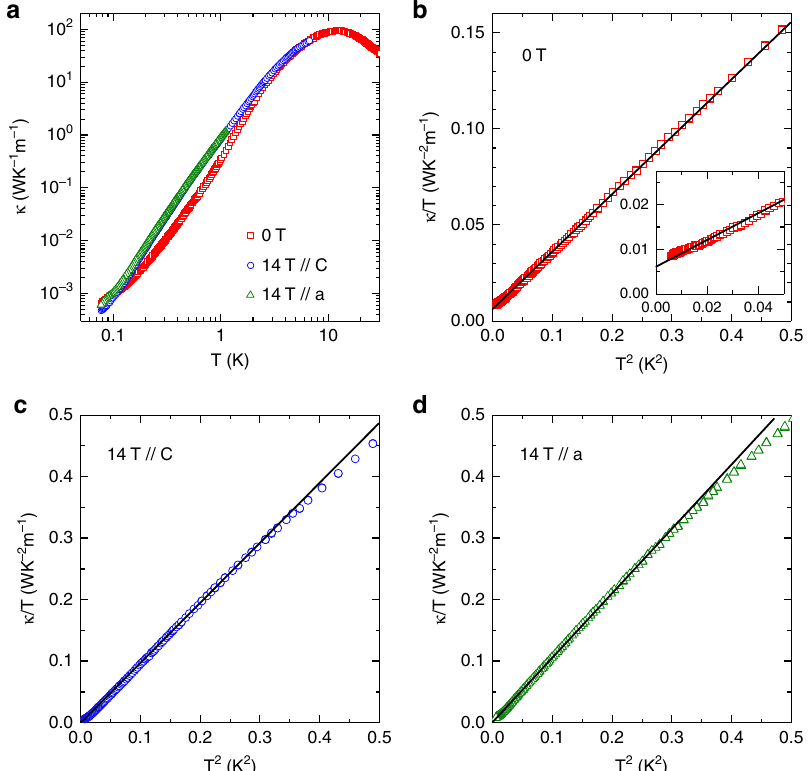
Fig. 2 Ultralow-temperature thermal conductivity of Na 2 BaCo(PO 4 ) 2 . a The zero- fi eld thermal conductivity of Na 2 BaCo(PO 4 ) 2 in temperature range of 70 mK – 30 K. The heat current is along the a axis. The peak at 12 K is the so-called phonon peak. Also shown are the thermal conductivity in 14 T magnetic fi eld along the c or the a axis. In most of this temperature region, high magnetic fi eld enhances the thermal conductivity. b Data in zero fi eld plotted in κ / T vs T 2 . The solid line is a linear fi t of the data at T < 700 mK. A nonzero residual thermal conductivity κ 0 / T = 0.0062 WK − 2 m − 1 is resolved. The inset shows a magni fi ed view of the lowest-temperature data. There is a very weak anomaly at T < 100 mK. c , d Thermal conductivity in 14 T magnetic fi eld plotted as κ / T vs T 2 . The solid lines are a linear fi ts for data at T < 550 mK (for B // c ) and at T < 500 mK (for B // a ). There is no residual term ( κ 0 / T =